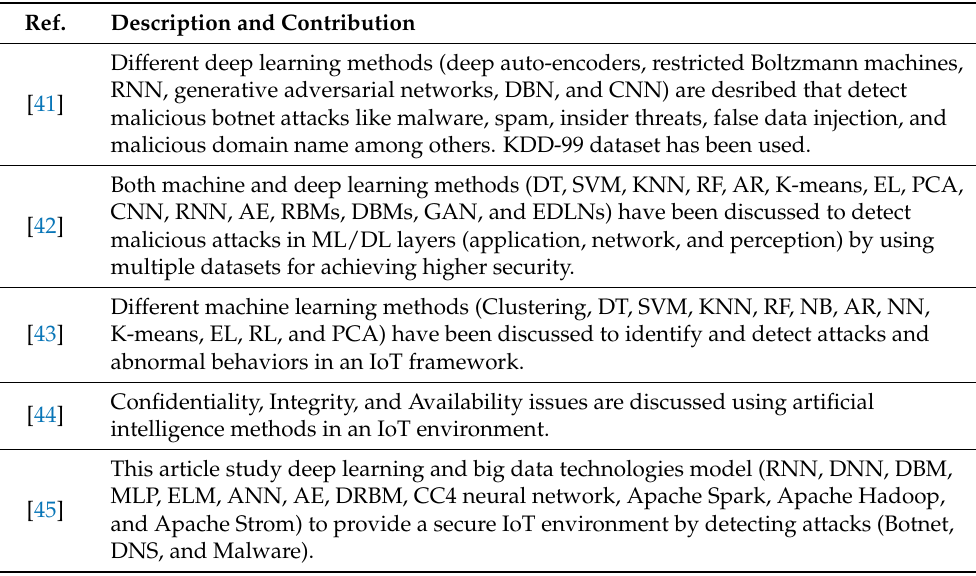
Table 2. Summary of review papers on detection of IoT cyber